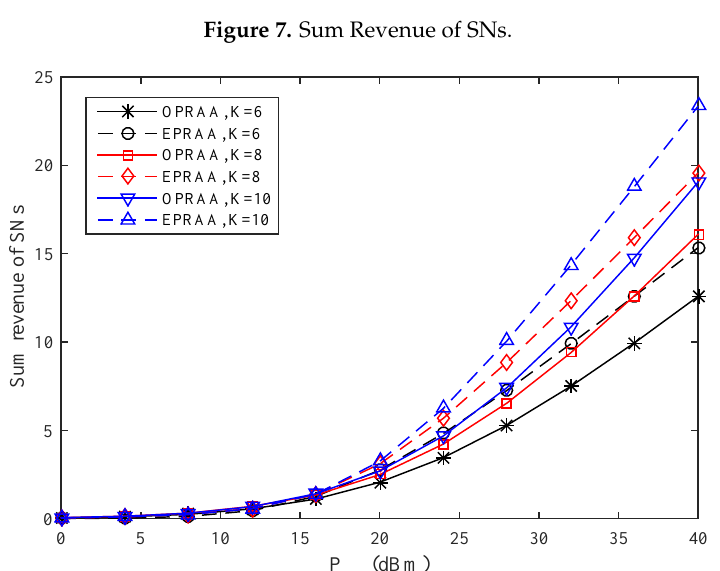
Figure 7. Sum Revenue of SNs.